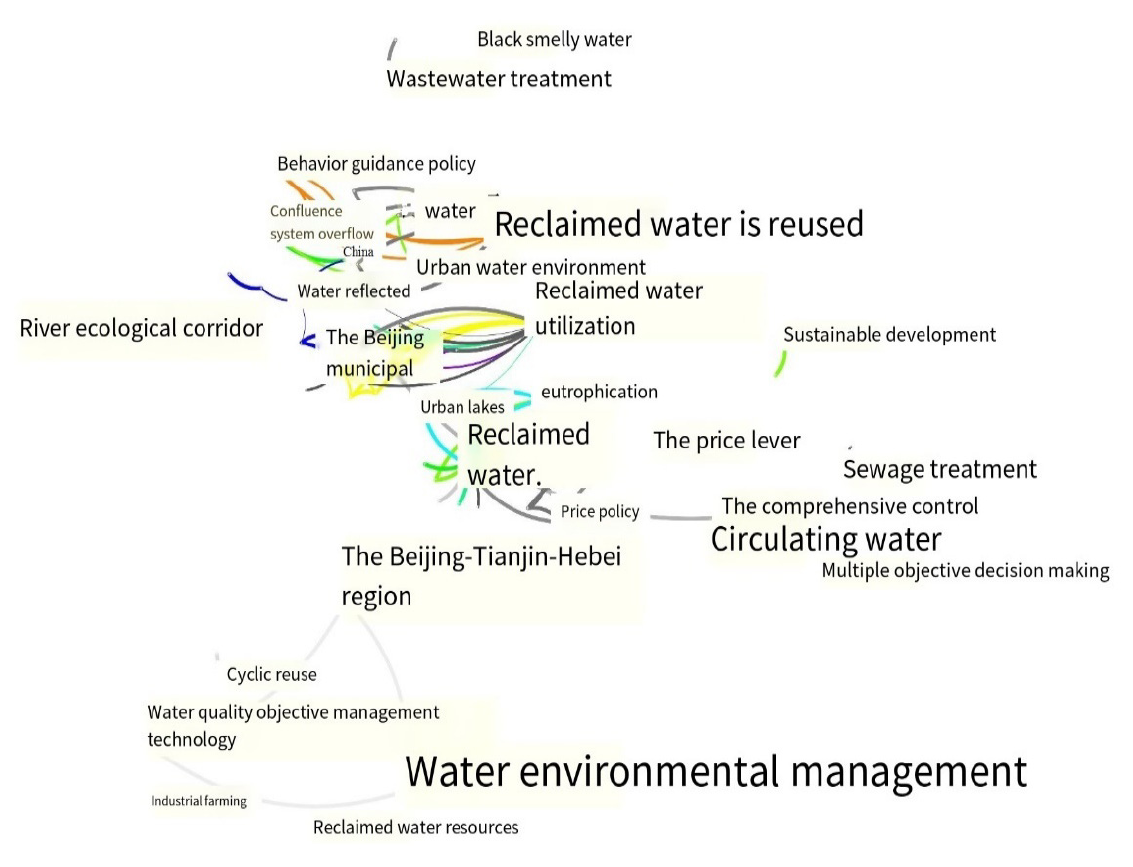
Figure 8. Cooccurrence of keywords in CNKI.